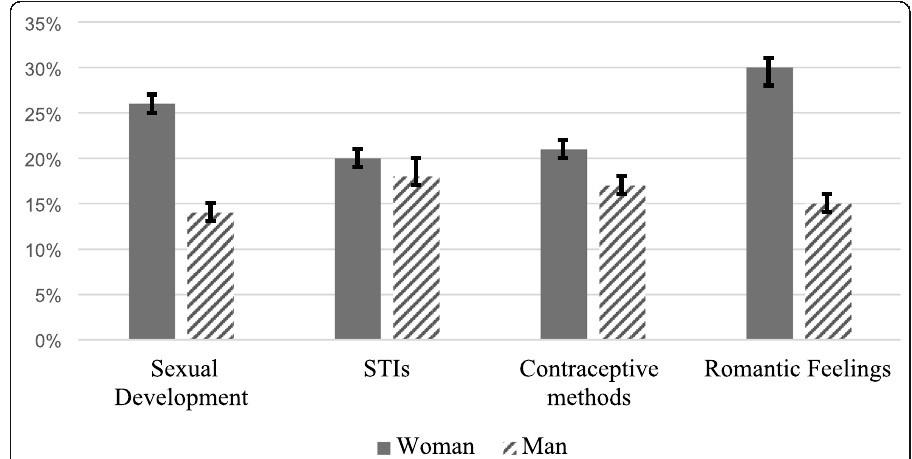
Fig. 2 Predicted probabilities to report having had a deep communication with parents about sex and romantic topics by respondents ’ gender. Results from logistic regression models. Source: SELFY (2000 and 2017). Note: N = 12,160; predicted probabilities with 95% confidence